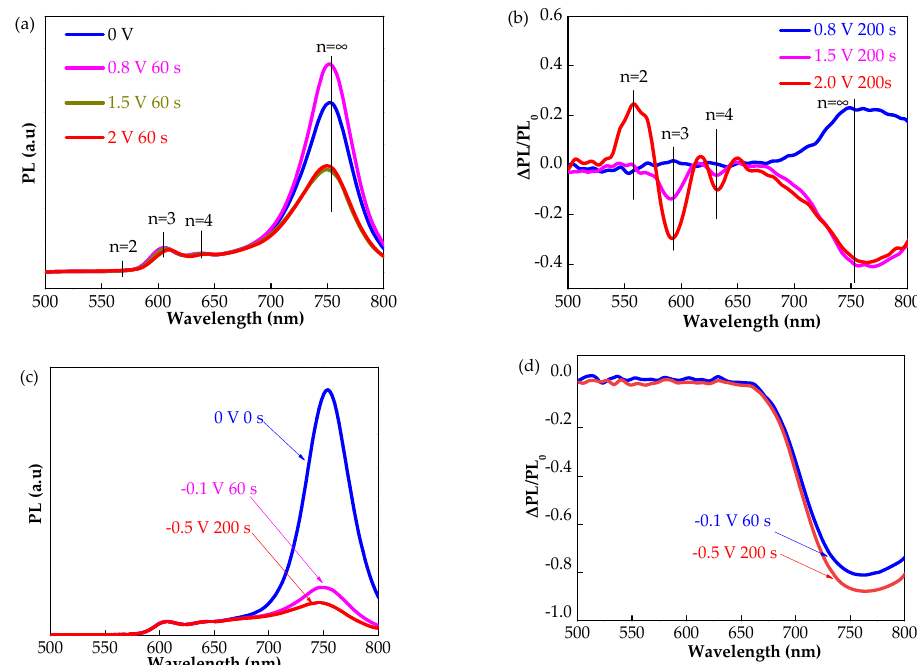
Figure 6. Optical characteristic spectra of electric field modulated quasi-2D perovskite solar cells. Under different, forward bias at constant time: ( a ) PL spectra. ( b ) Δ PL/PL 0 curve. Under other reversed bias with vary time: ( c ) PL spectra. ( d ) Δ PL/PL 0 curve.